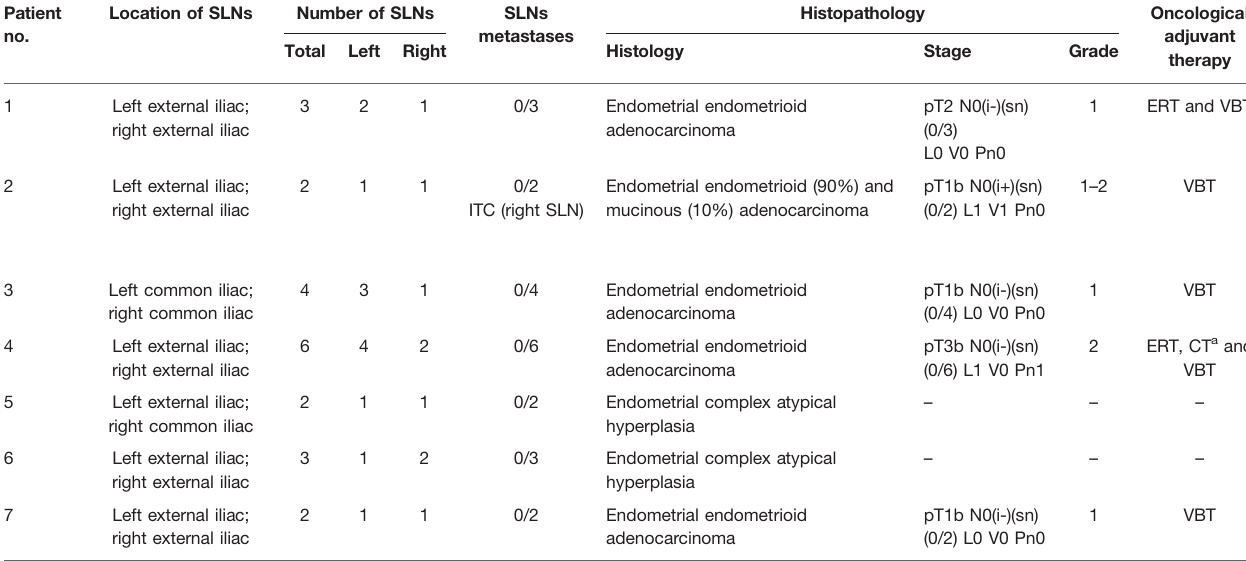
TABLE 2 | Characteristics of sentinel lymph nodes, histopathology, and oncological adjuvant therapy. Patient